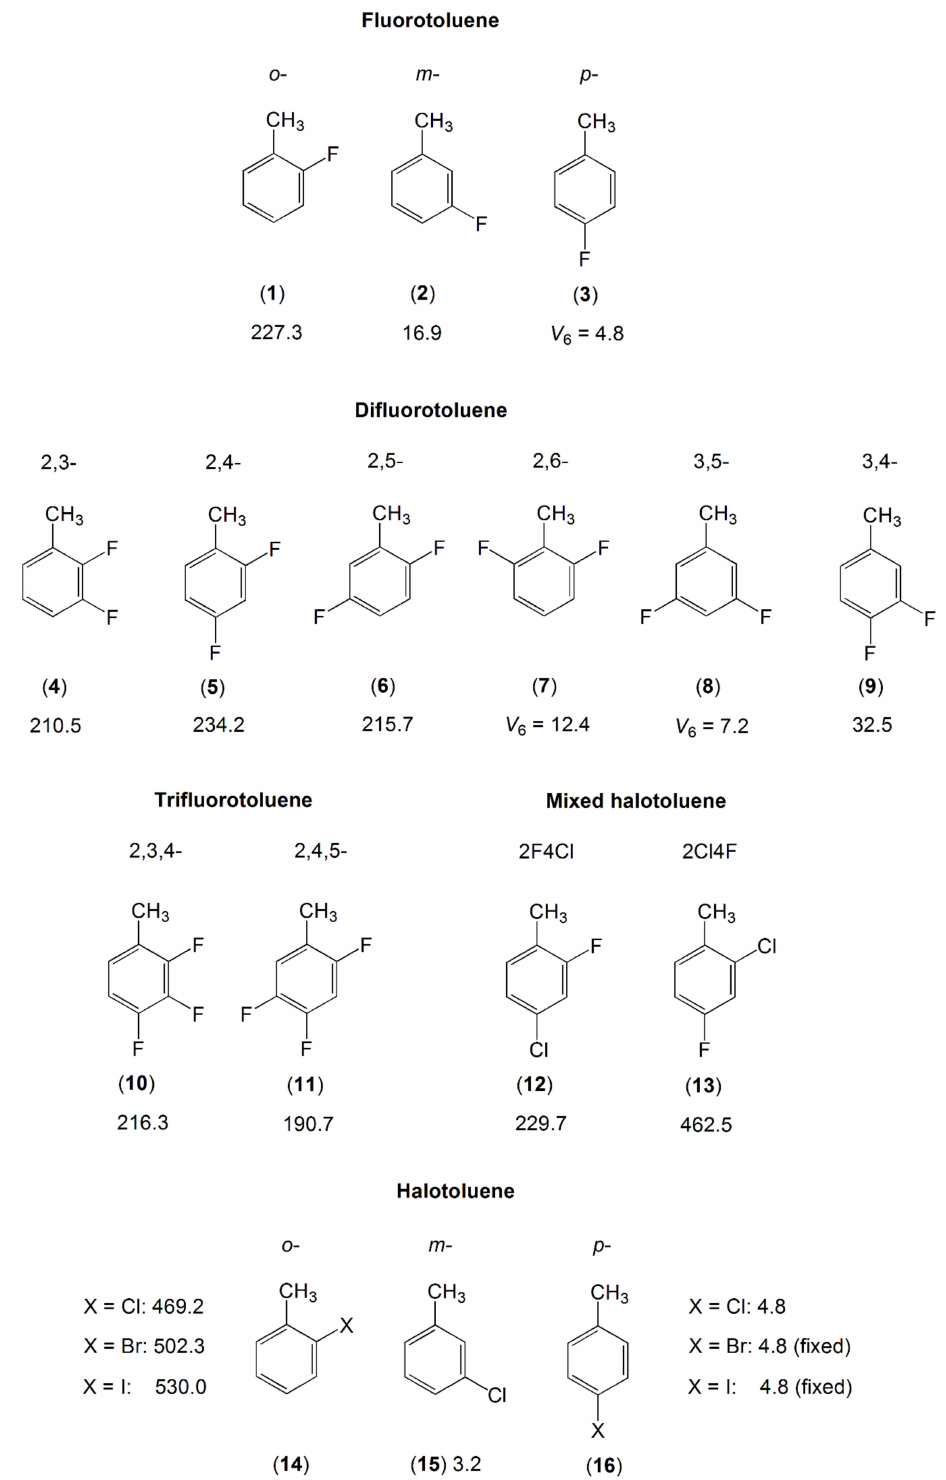
Figure 7. Barriers to methyl internal rotation in halogen-substituted toluene derivatives (in cm − 1 ). ( 1 ) o- fluorotoluene [161], ( 2 ) m-fluorotoluene [162,163], ( 3 ) p-fluorotoluene [164], ( 4 ) 2,3-difluorotoluene [165], ( 5 ) 2,4-difluorotoluene [166], ( 6 ) 2,5-difluorotoluene [167], ( 7 ) 2,6-difluorotoluene [168], ( 8 ) 3,5- difluorotoluene [168], ( 9 ) 3,4-difluorotoluene [163,169], ( 10 ) 2,3,4-trifluorotoluene [170], ( 11 ) 2,4,5- trifluorotoluene [170], ( 12 ) 2-fluoro-4-chlorotoluene [129], ( 13 ) 2-chloro-4-fluorotoluene [130], ( 14 ) o- X-toluene [128], ( 15 ) m-chlorotoluene [171], ( 16 ) p-X-toluene [172], X = Cl, Br,